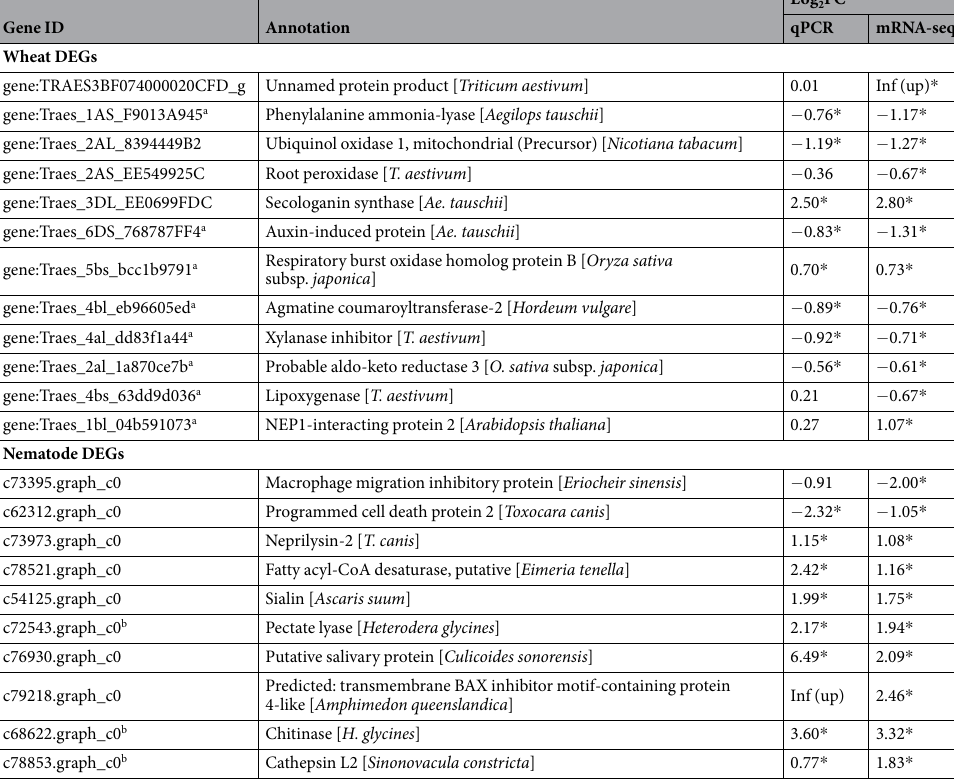
Table 2. Validation of mRNA-Seq data of a selected set of wheat and Heterodera avenae genes with quantitative real-time PCR (qPCR) to confirm gene expression changes at the contact stage (treatment versus control). Inf (up) indicates that the expression of the gene was detected only in the treatment sample, but not the control sample. * P < 0.05. FC, fold change (treatment vs. control). a The DEGs were involved in biotic stress pathways of wheat created using MapMan visualization. b The DEGs were predicted effector genes in Heterodera avenae exposed to wheat roots.